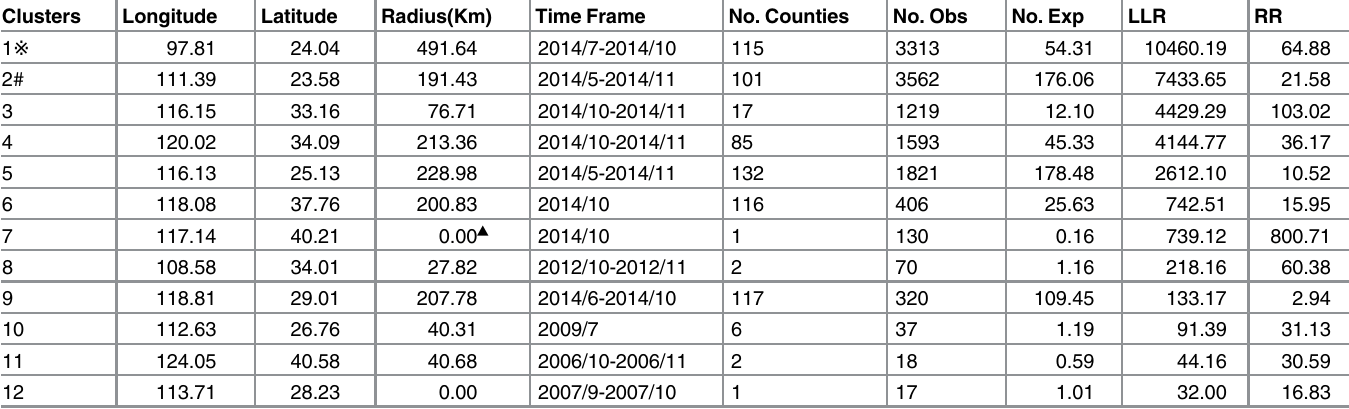
Table 3. Spatiotemporal clusters of scrub typhus detected using Kulldorff ’ s space-time scan statistic in mainland China * , 2006 – 2014. Clusters